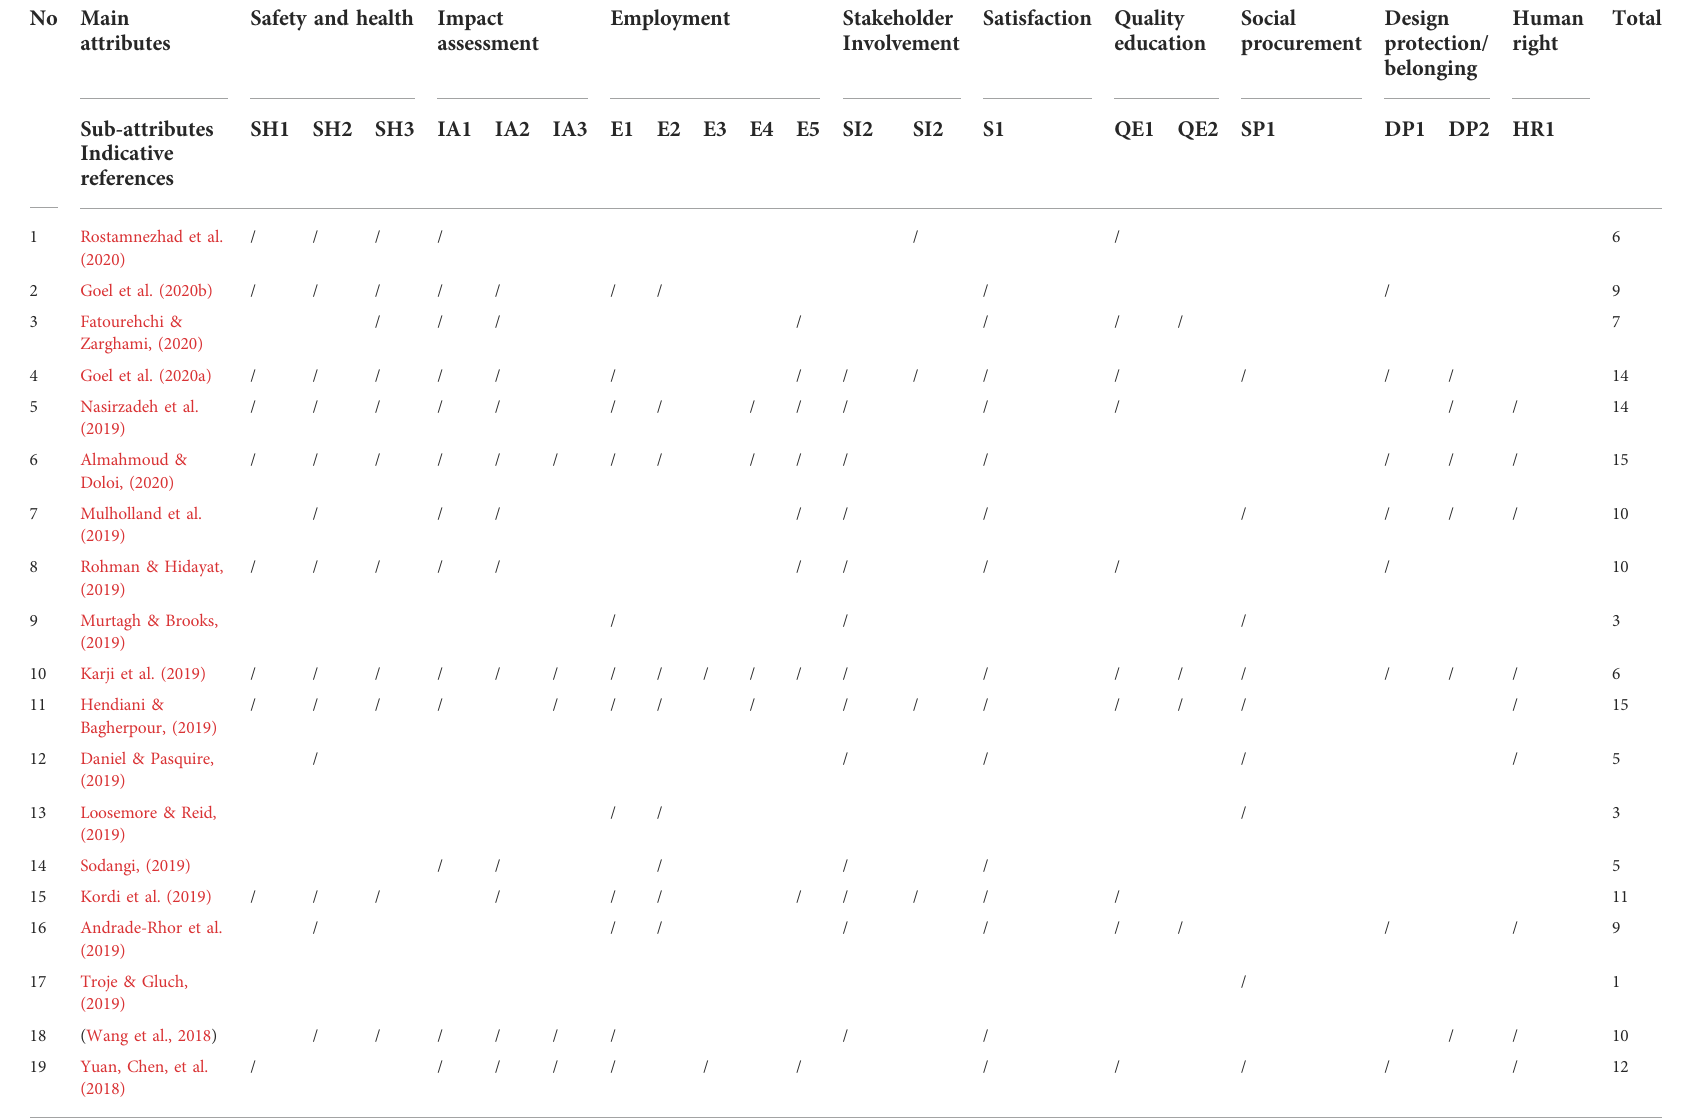
TABLE 1 The main and sub-attributes of social sustainability in construction projects. No Main